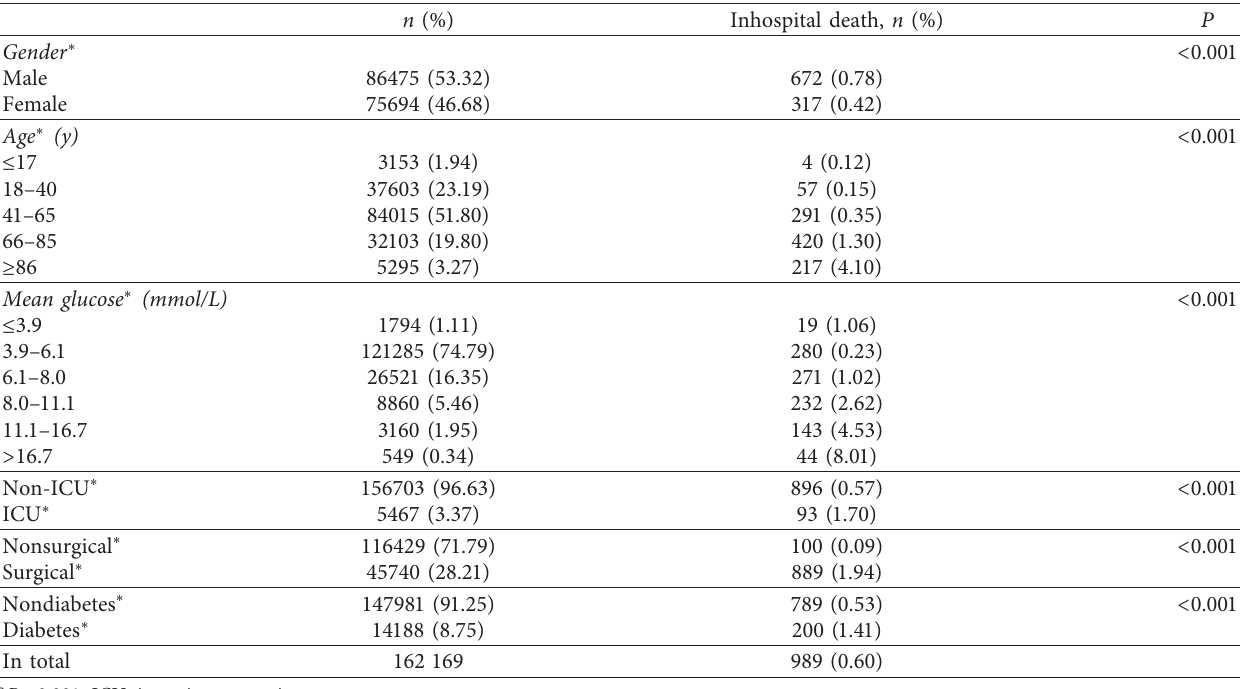
Table 1: Characteristics of the study